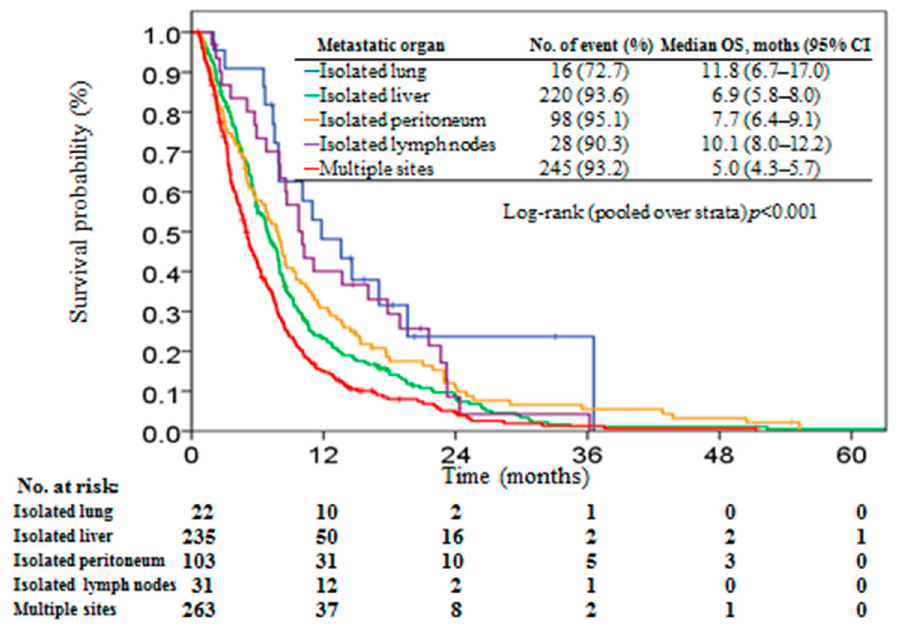
Figure 2. Kaplan–Meier plot of overall survival in stage IV pancreatic patients stratified by metastatic organ.